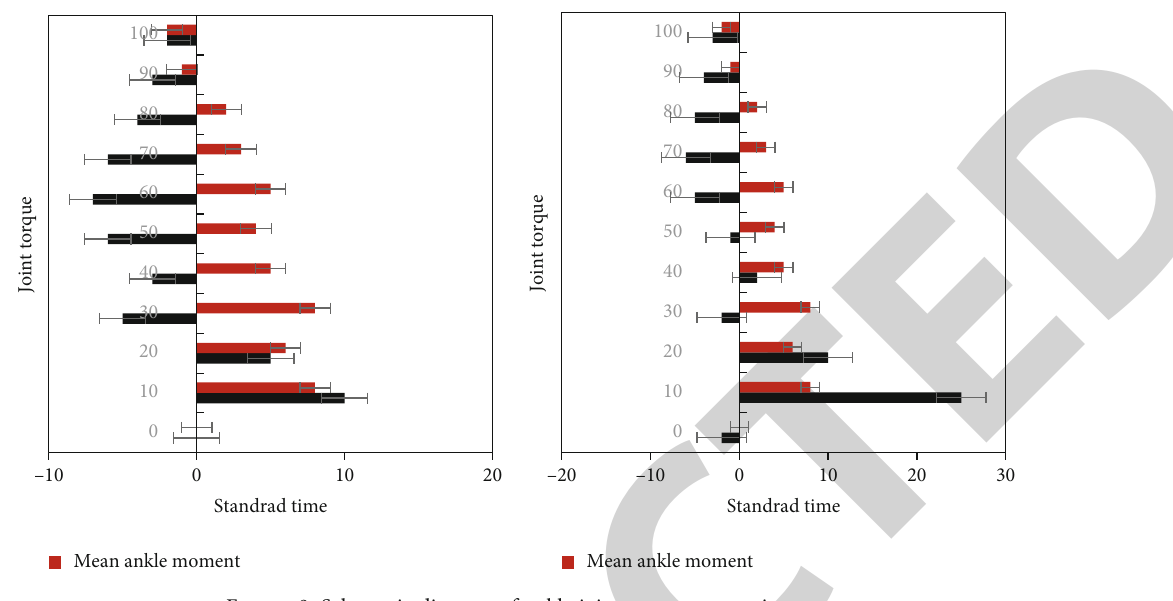
Figure 9: Schematic diagram of ankle joint torque comparison. Table 4: Comparison of peak muscle movements of the hip, knee and ankle joints in test jumps between groups A and B.